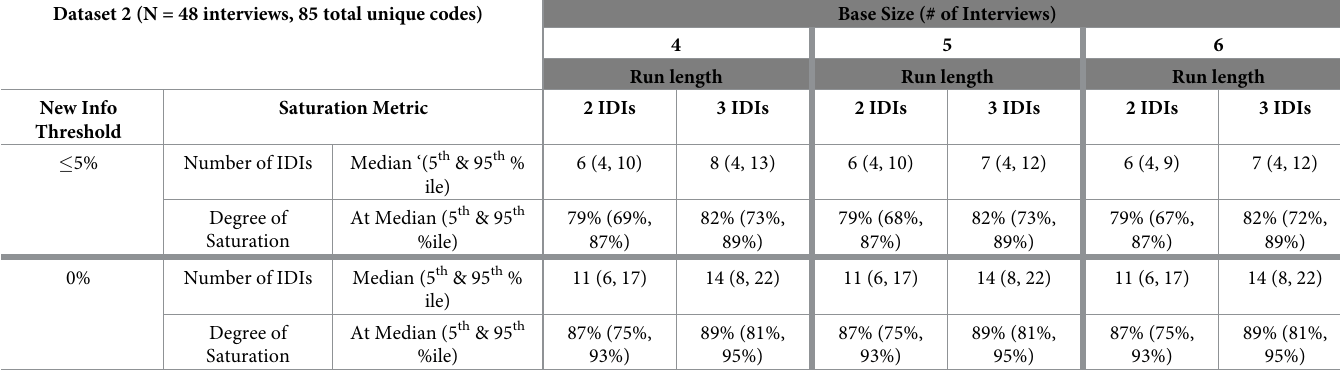
Table 3. Dataset 2 bootstrap distribution: Median number of interviews to reach saturation and degree of saturation at different base sizes and run lengths. Dataset 2 (N = 48 interviews, 85 total unique